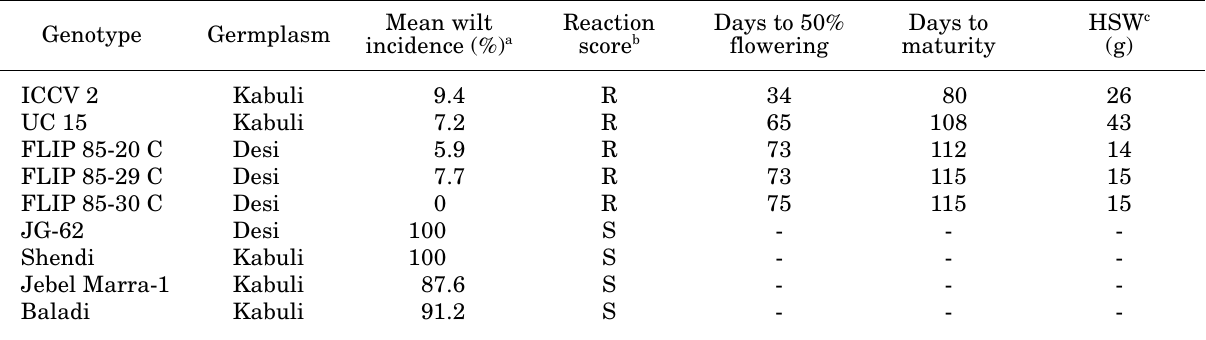
Table 1. Wilt incidence, reaction scores and some agronomic characteristics of selected chickpea genotypes in a wilt- infected plot at Hudeiba Research Station, Ed-Damer, Sudan, screened from 1989 to 1995. Mean wilt